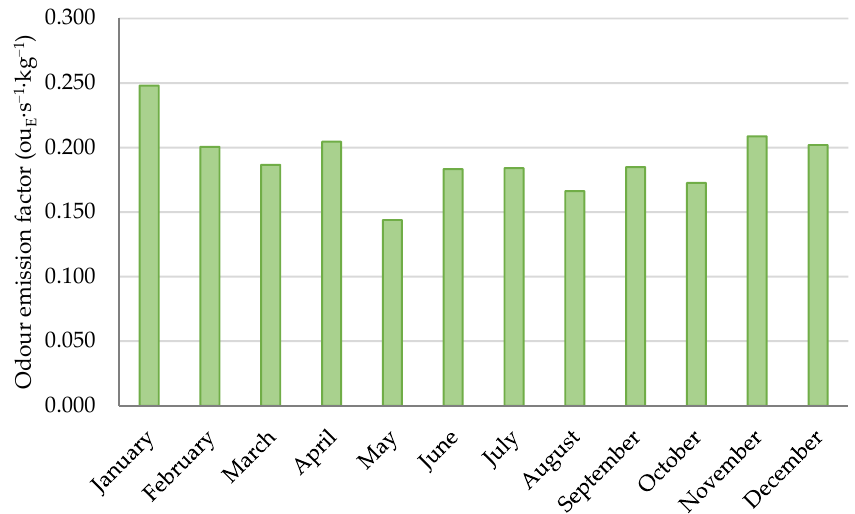
Figure 12. Odour emission factors for dairy cows.